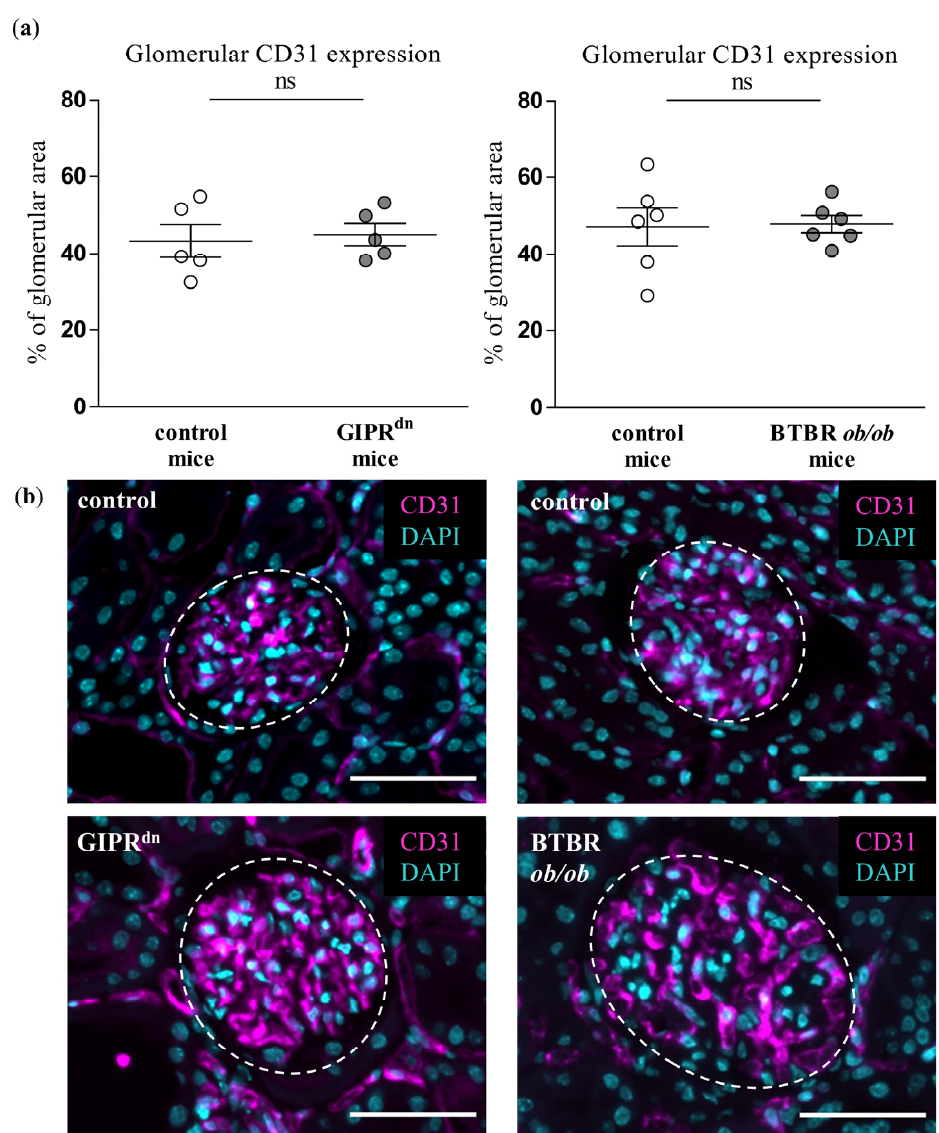
Figure 2. Analysis of CD31 in diabetic kidney disease models. ( a ) Automatic histological evaluation of CD31-positive area in glomeruli of GIPR dn mice ( left , diabetes mellitus type 1 model) and BTBR ob/ob mice ( right , diabetes mellitus type 2 model) compared to their corresponding healthy control mice. Scatter dot plot with means and SEM, ns: not significant, n = 5–6. ( b ) Representative images of histological kidney sections stained for CD31 (magenta) and the nuclear marker 4 ′ ,6-diamidino-2- phenylindole (DAPI, cyan). The dashed line borders the glomeruli. Scale bar: 50 µm.